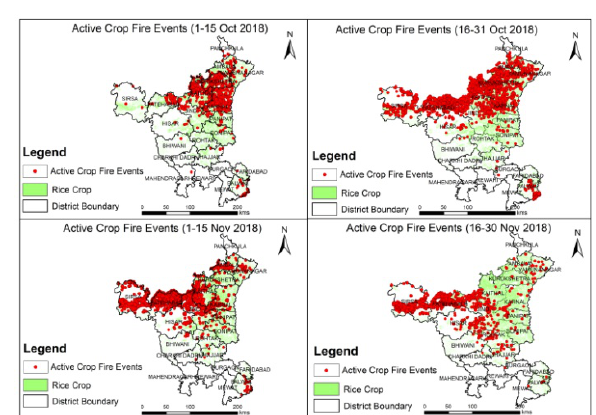
Figure 5. Fortnightly comparison of active fire events detected